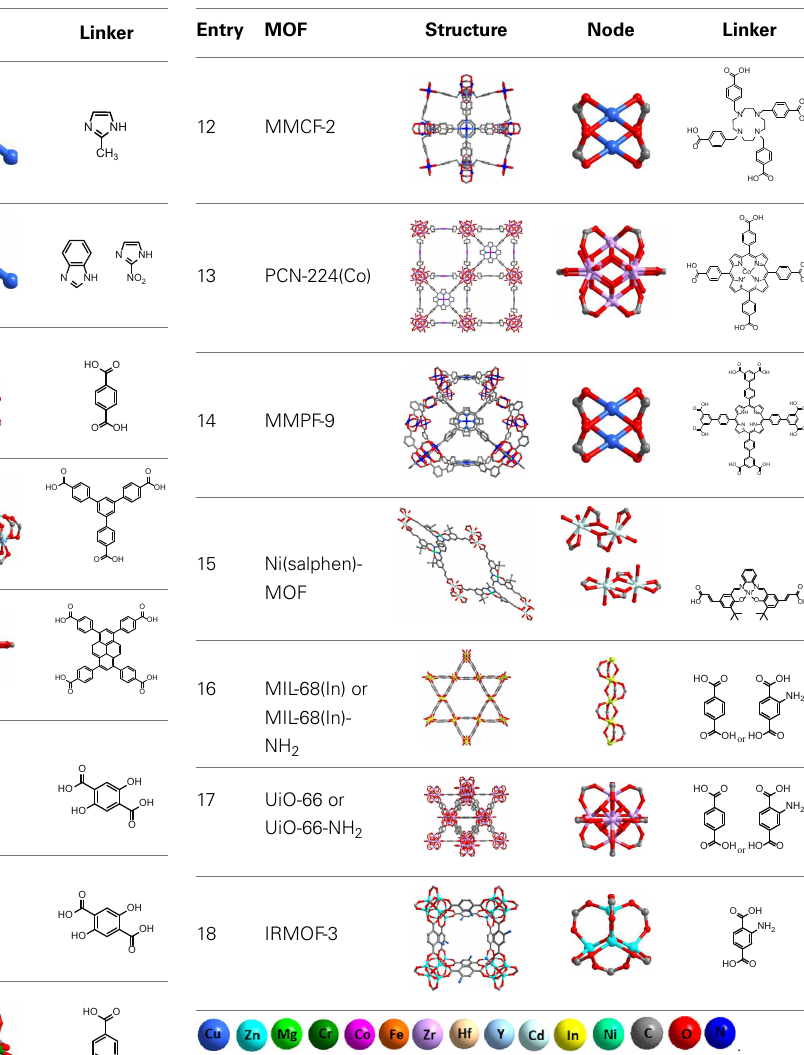
Table 1 | Structural details of the MOFs, which have been used as catalysts for the cycloaddition of CO 2 to epoxides leading to five-membered ring OCs